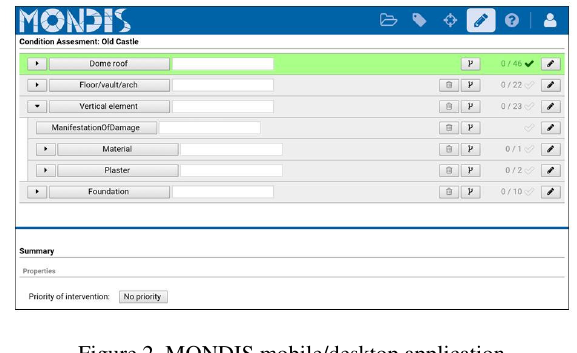
Figure 2. MONDIS mobile/desktop application